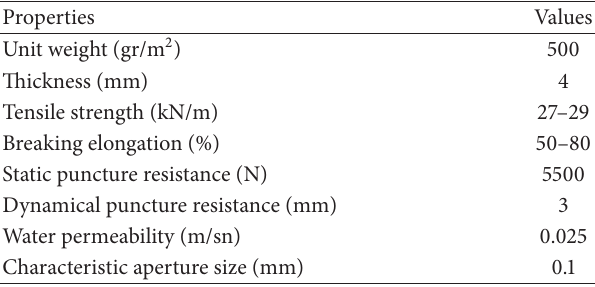
Table 3: Technical properties of nonwoven geotextile.